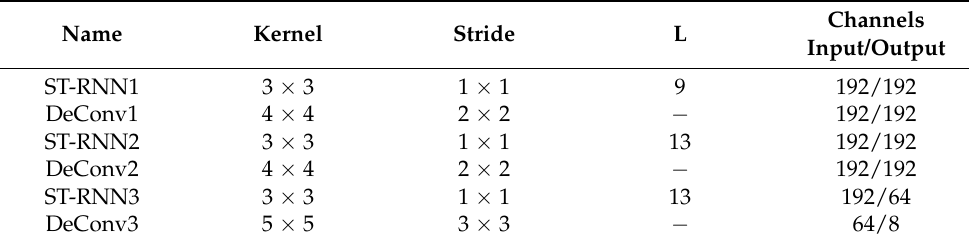
Table 2. General structure of the decoder of the proposed spatiotemporal RNN model (stage